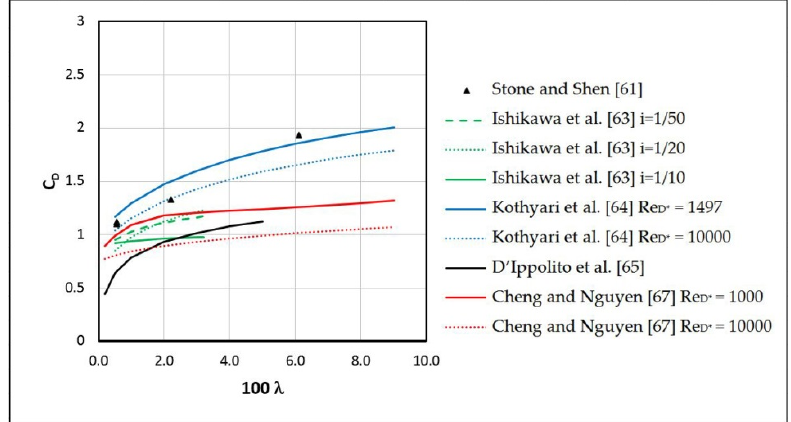
Figure 4. Emergent rigid vegetation— 𝐶 𝐷 as a function of 𝜆 and 𝑅𝑒 𝐷 .